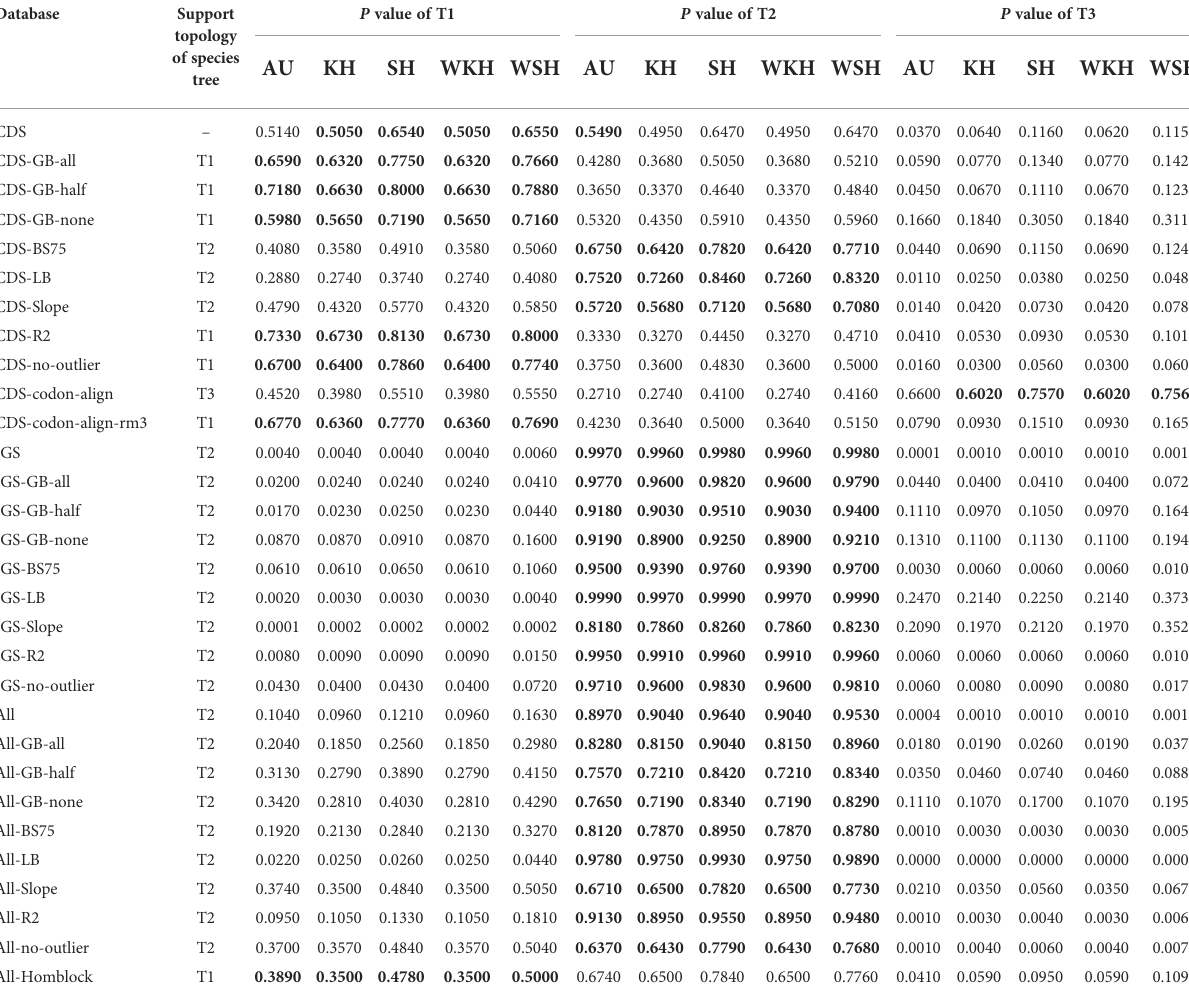
TABLE 1 Statistical tests of alternative hypotheses on the phylogenetic relationships of Dennstaedtiaceae.